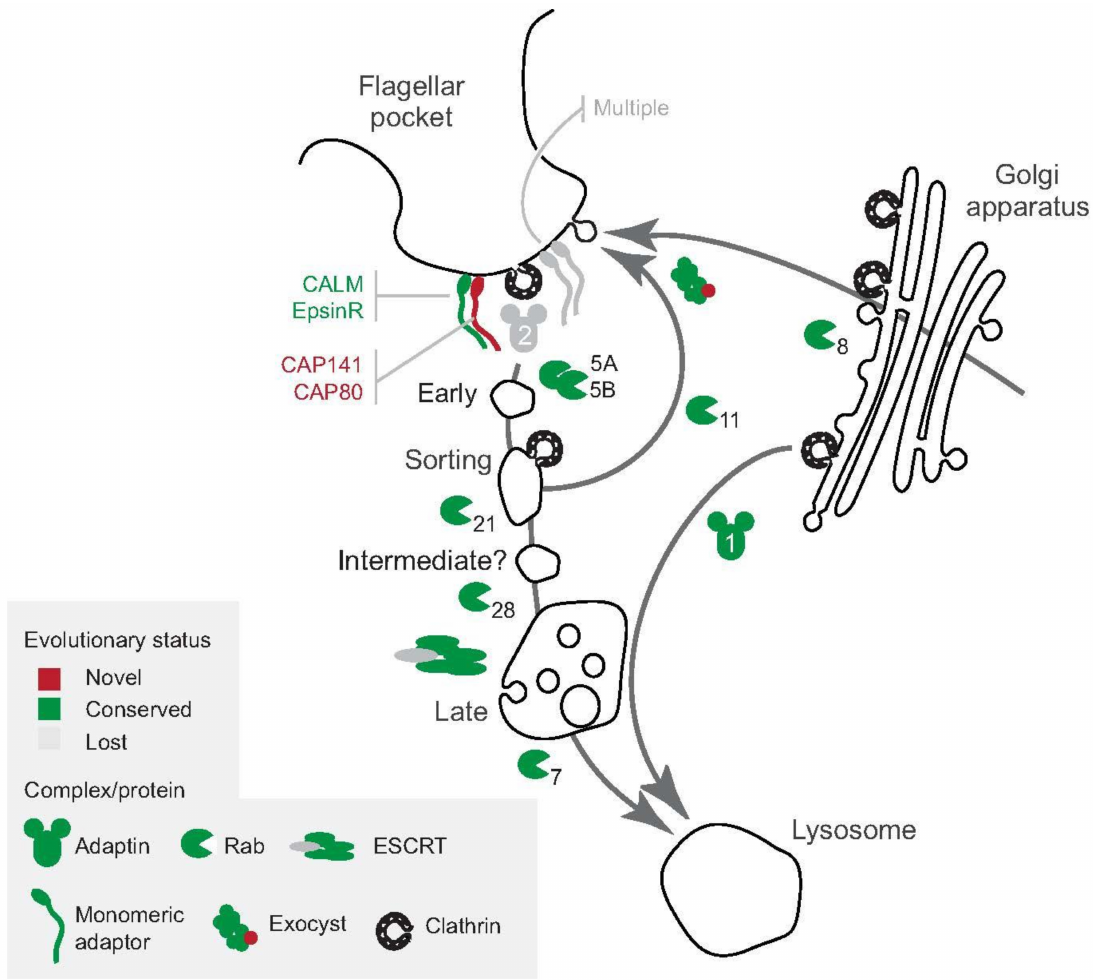
Figure 2. Organization of the endomembrane system of bloodstream form of T. brucei sp. A simplified schematic representation of the trypanosome endomembrane system is shown, with the flagellar pocket at the top of the panel, and including other intracellular organelles, such as the trans-Golgi network (TGN), early, sorting and intermediate endosomes, and the lysosome. Intracellular trafficking routes are indicated by arrows, with the arrowheads pointing towards the destination of traffic. The endocytic route is depicted from the pocket to various intracellular organelles, whereas the exocytic route is depicted from intracellular organelles (TGN, endosomes) to the surface. The cohort of conserved trafficking-related protein between trypanosomes and higher eukaryotes is shown in green, whereas lineage-specific proteins, i.e. those present only in trypanosomes (and possibly a few additional taxa) are indicated in red. Similarly, those components not detected in trypanosomes, and therefore thought to be lost in these organisms (e.g. the adaptor protein 2 complex) are shown in grey. Rab proteins are also shown and positioned based on the step that they mediate as well as localisation data (e.g. Rab5 in early endosomes, Rab11 in sorting/recycling endosomes). Note that not all proteins and complexes shown are discussed in the text but are present for completeness. Abbreviations: ESCRT; endosomal sorting complexes required for transport, CALM; clathrin assembly lymphoid myeloid leukemia, CAP; clathrin-associated proteins, EpsinR; Eps15-interacting protein (Epsin)-related protein. Numbers in endosomal structures (early, sorting, intermediate, and late) represent the corresponding Rab protein (e.g. Rab5A, Rab5B, Rab11, Rab21, Rab28,